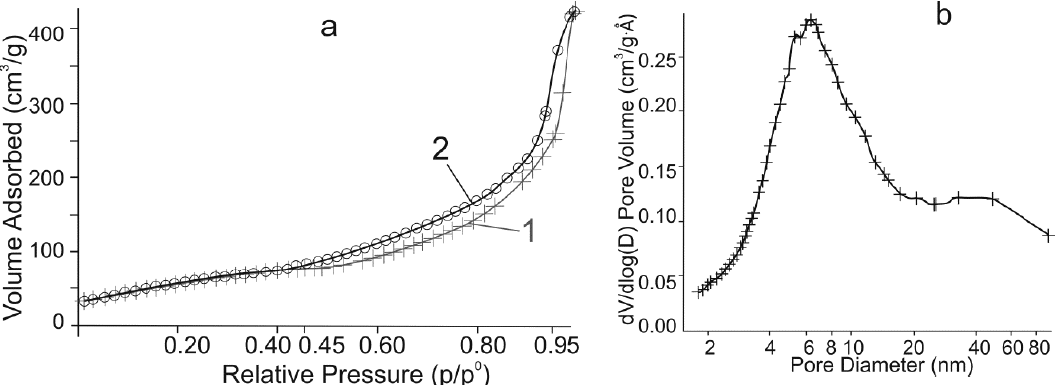
Figure 4. ( a ) N 2 adsorption (1) and desorption (2), and ( b ) Barrett-Joyner-Halenda (BJH) desorption pore size distribution of titanium phosphate.